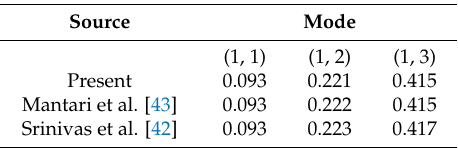
Table 4. Comparison of non-dimensional frequency parameter of the simply supported square isotropic plate.